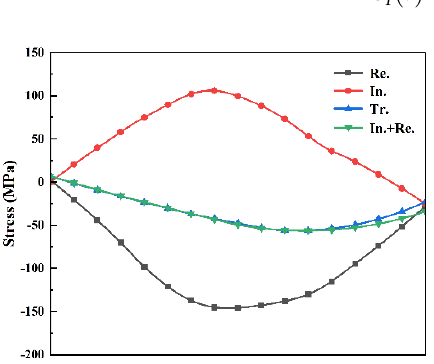
Figure 3. Typical test curve for stress equalization.